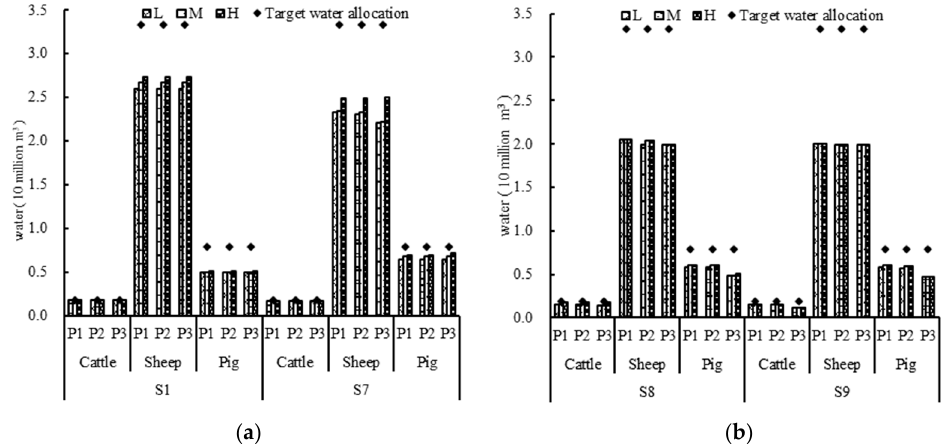
Figure 8. The livestock husbandry water allocation in Bayan Nur City under the four scenarios of ( a ) S1 and S7 and ( b ) S8 and S9.